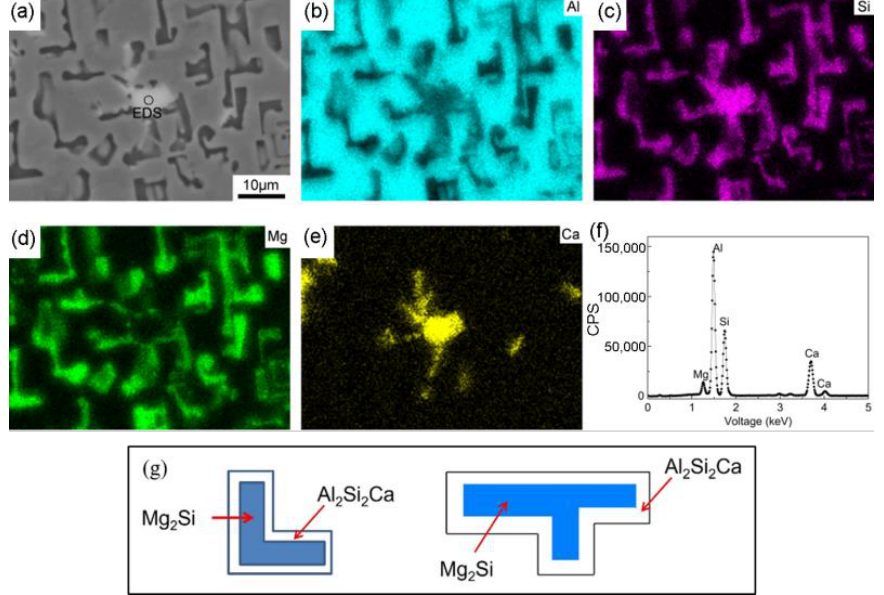
10 of 16 ( c ) the corresponding selected area diffraction pattern taken parallel to the electron beam direction of [011] α -Al . In addition, in order to elucidate the effect of Ca on the shape of the eutectic Mg 2 Si phase, Figure 12a shows the presence of the Al 2 Si 2 Ca intermetallic in the Al-Mg-Si alloy system containing 500 ppm Ca. Figure 12b – e shows the corresponding elemental maps, while Figure 12f represents the EDS spectrum taken from the location, as shown in Figure 12a. It should be noted that, at the higher levels of Ca, the morphology of Mg 2 Si is changed from fibers or globules to a block/or plate. Figure 12g shows a schematic diagram, which indicates the presence of Al 2 Si 2 Ca at the growing interfaces of the Mg 2 Si phase. Further- more, Figure 13 shows the plate-shaped Mg 2 Si phase. No Ca-rich layer was observed